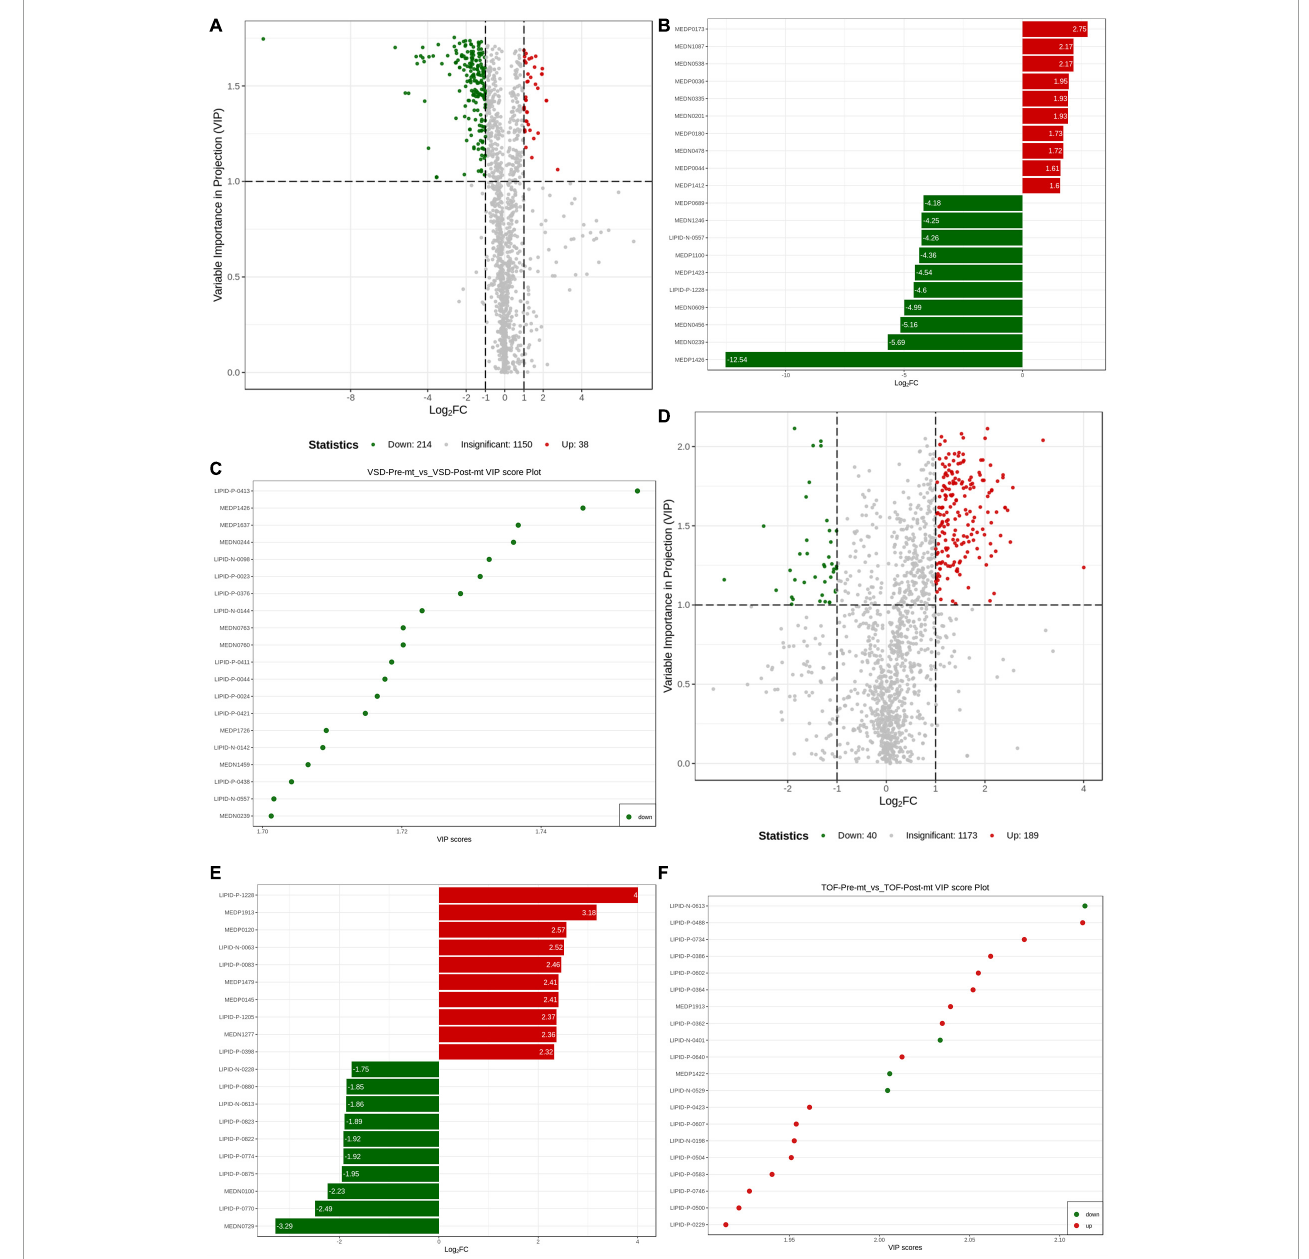
FIGURE5 Differential metabolite analysis. (A) Volcanogram of differential metabolites in atrial septal defect (ASD) samples. (B) Up- and down-regulated of the top 10 metabolites in ASD samples. (C) Top 20 differential metabolites by VIP value in ASD samples. (D) Volcanogram of differential metabolites in tetralogy of fallot (TOF) samples. (E) Up- and down-regulated of the top 10 metabolites in TOF samples. (F) Top 20 differential metabolites by VIP in TOF